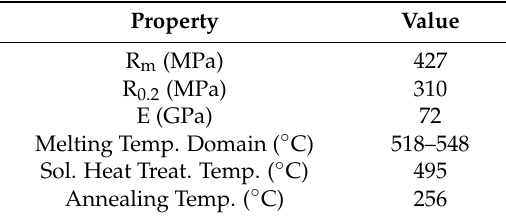
Table 2. Summarized AA2024-T351 properties